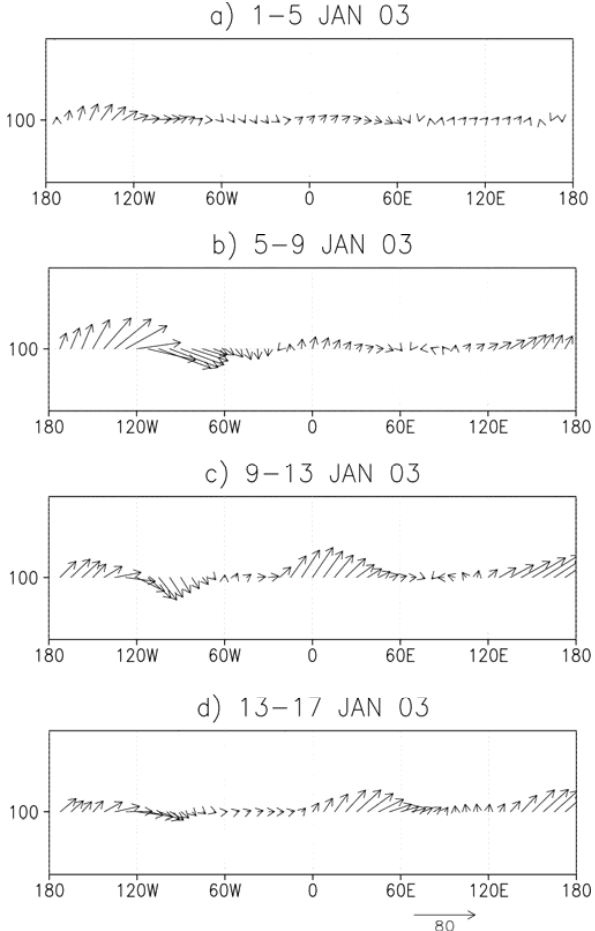
Fig. 11. Altitude-longitude cross-section of mean Plumb flux vec- Figure 11: Altitude-longitude cross-section of mean Plumb flux vector (m 2 s -2 ) at 100 hPa tor (m 2 s − 2 ) at 100hPa averaged over the latitudinal belt 40 ◦ –60 ◦ N based on 5-day means for the 1–17 January-period. The scale fac- tor of the fluxes is 80 as indicated by the arrow below the last panel. averaged over the latitudinal belt 40°-60° N based on 5-day means for the 1-17 January The vertical component of wave activity flux is multiplied by a fac- tor of period. The scale factor of the fluxes is 80 as indicated by the arrow below the last panel. The vertical component of wave activity flux is multiplied by a factor of 100.